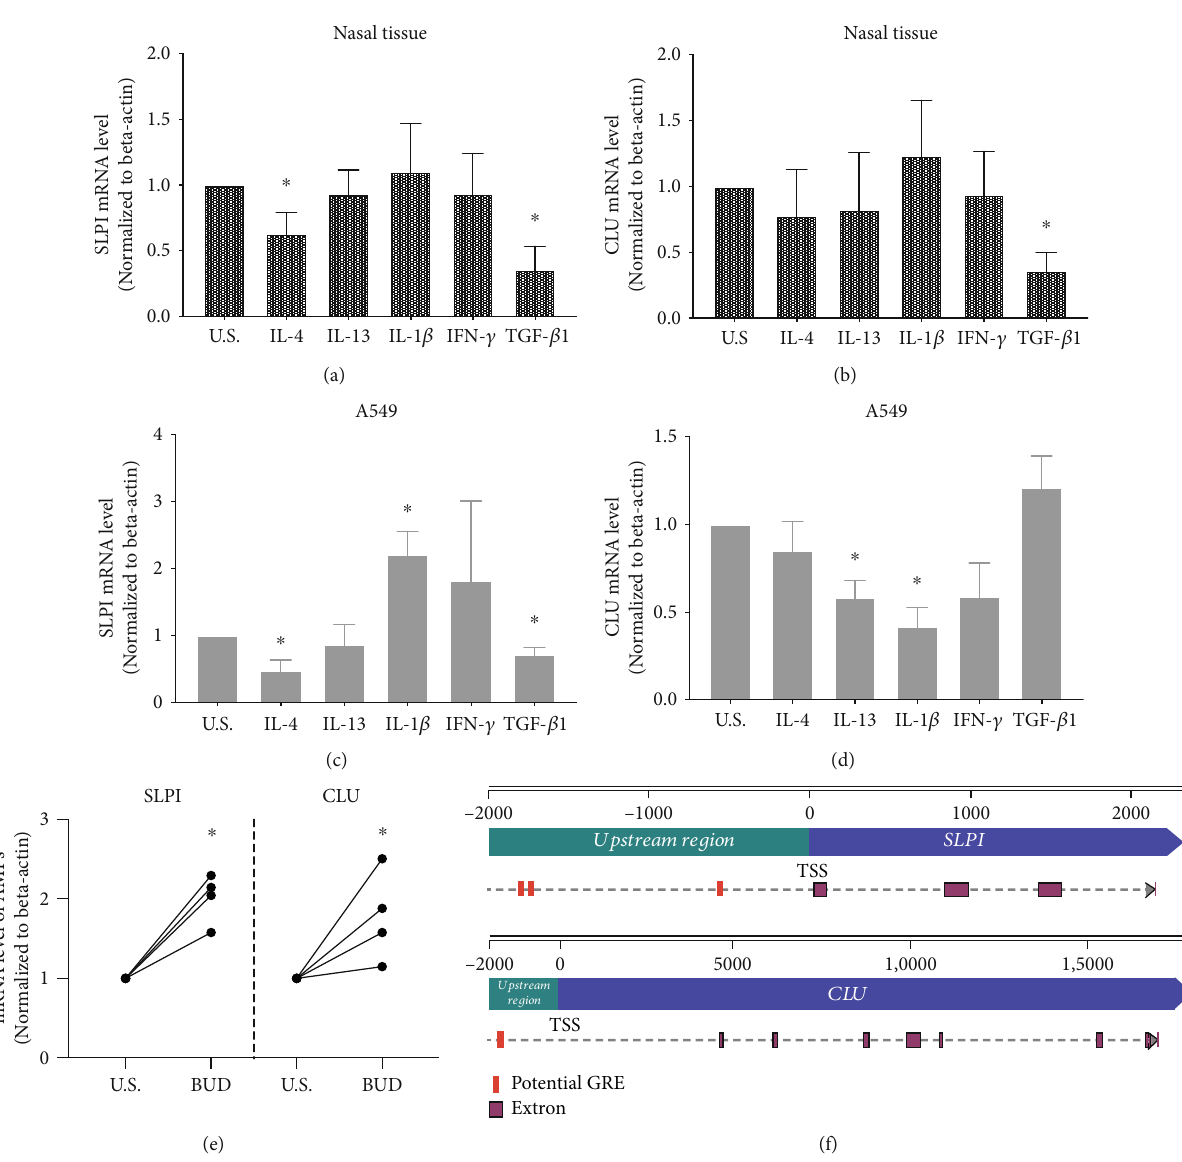
Figure 6: Regulation of SLPI and CLU by cytokines and glucocorticoid. (a – d) The expression level of SLPI (a, c) and CLU (b, d), detected by real-time PCR, in cultured human nasal tissues and A549 cells after 48 hours of stimulation by cytokines or unstimulated control. (e) The upregulated mRNA level of SLPI and CLU in cultured nasal tissues after 48 hours of stimulation by budesonide. (f) Potential glucocorticoid response element in the upstream region of SLPI and CLU. ∗ P < 0 : 05 ; CLU: clusterin; SLPI: secretory leukoprotease inhibitor; BUD: budesonide; U.S.: unstimulated control; GRE: glucocorticoid response element; TSS: transcription